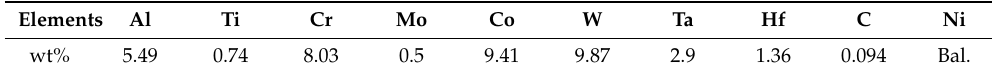
Table 1. The composition of superalloy CM247LC in wt%.